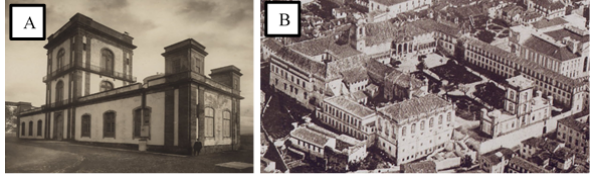
Figure 2. The first building of the astronomical observatory, in “Paço das Escolas”, designed by Manuel Macomboa (A) [Source: Ilus- tração Portugueza , 1907]. Aerial view of the University of Coimbra (B), in 1945, just before the demolition of the observatory building [Source: Bandeira (1943)].